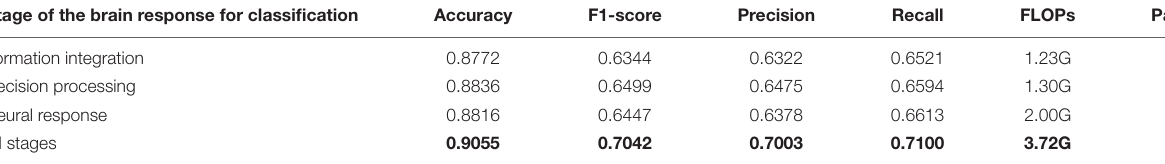
TABLE 4 | Comparison of effects of using the data in different stages on classification